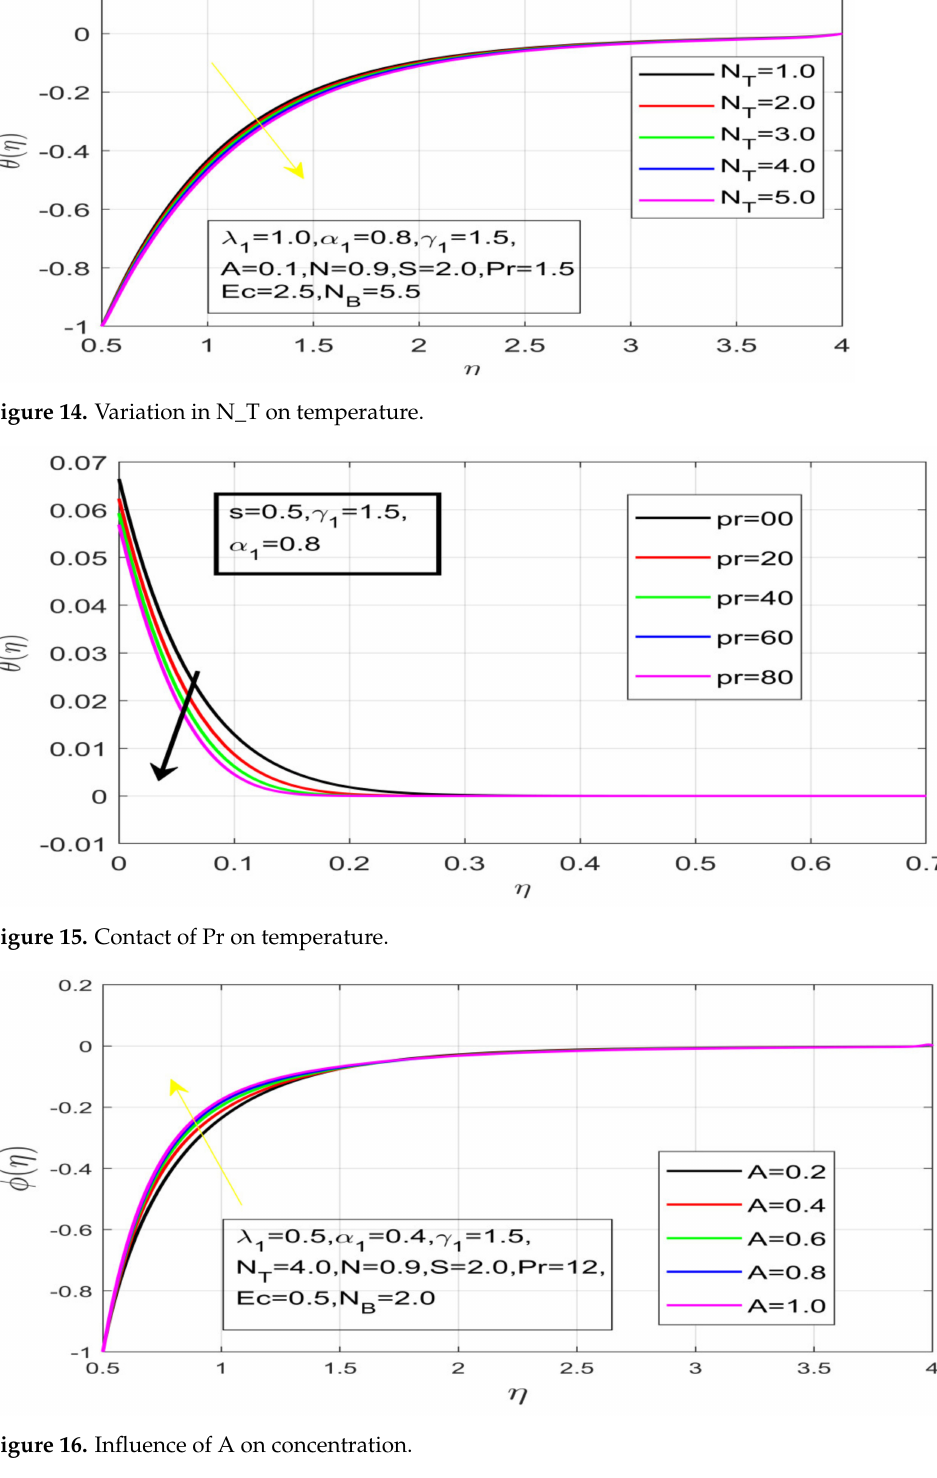
Figure 16. Influence of A on